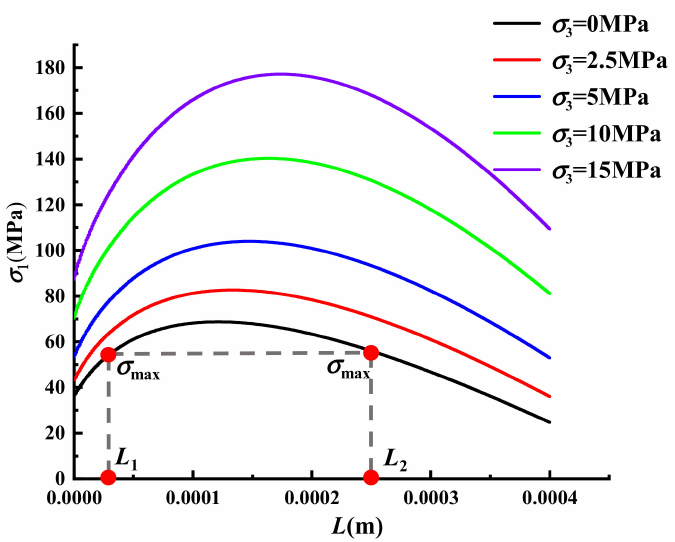
Figure 8. Variation process of wing crack length with axial stress under different confining pressures.